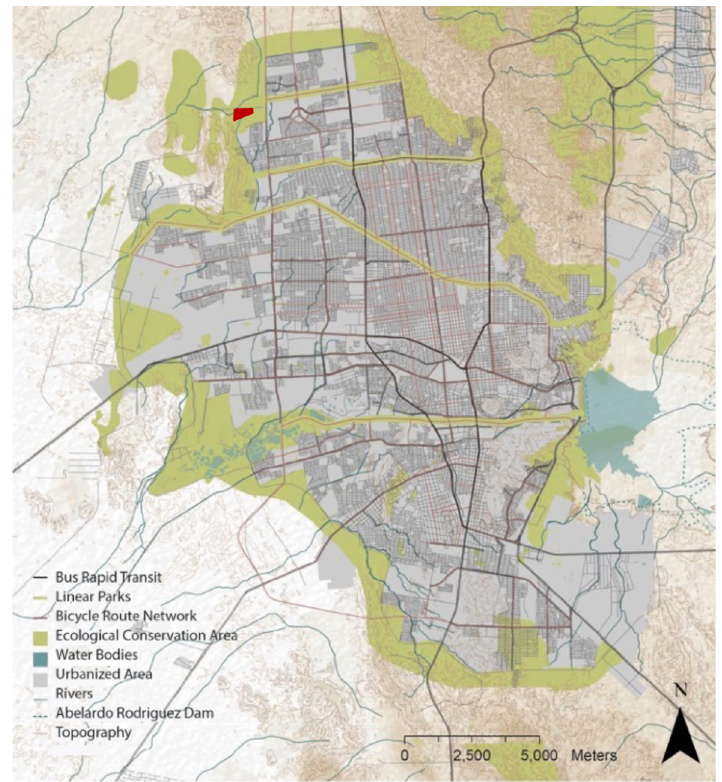
Figure 5. Site selection for stormwater park within the green belt in Hermosillo (red polygon within the light green area on the northwest of the city) (credit: C. Scarpitti based on IMPLAN map). During the fall semester 2021, the designers were split into four different teams. The teams provided four different masterplans for the park, each highlighting differing yet important programmatic aspects such as recreation and leisure; conservation and restora- tion; education and youth engagement; and economic development. Although each team emphasized different design aspects while employing various approaches, all teams used GI strategies to incorporate stormwater runoff and planting designs to provide multiple ecosystem services. A common thread in these masterplans was to protect the ephemeral arroyos. The initial design projects produced by the four teams of students were presented to the stakeholders, including the IMPLAN officials, members of the two NGOs, and aca- demics engaged in the collaboration. Based on their feedback, a graduate student designer synthesized and compiled the four designs, incorporating the most prominent and desir- able design features from the four design proposals (Figure 6).